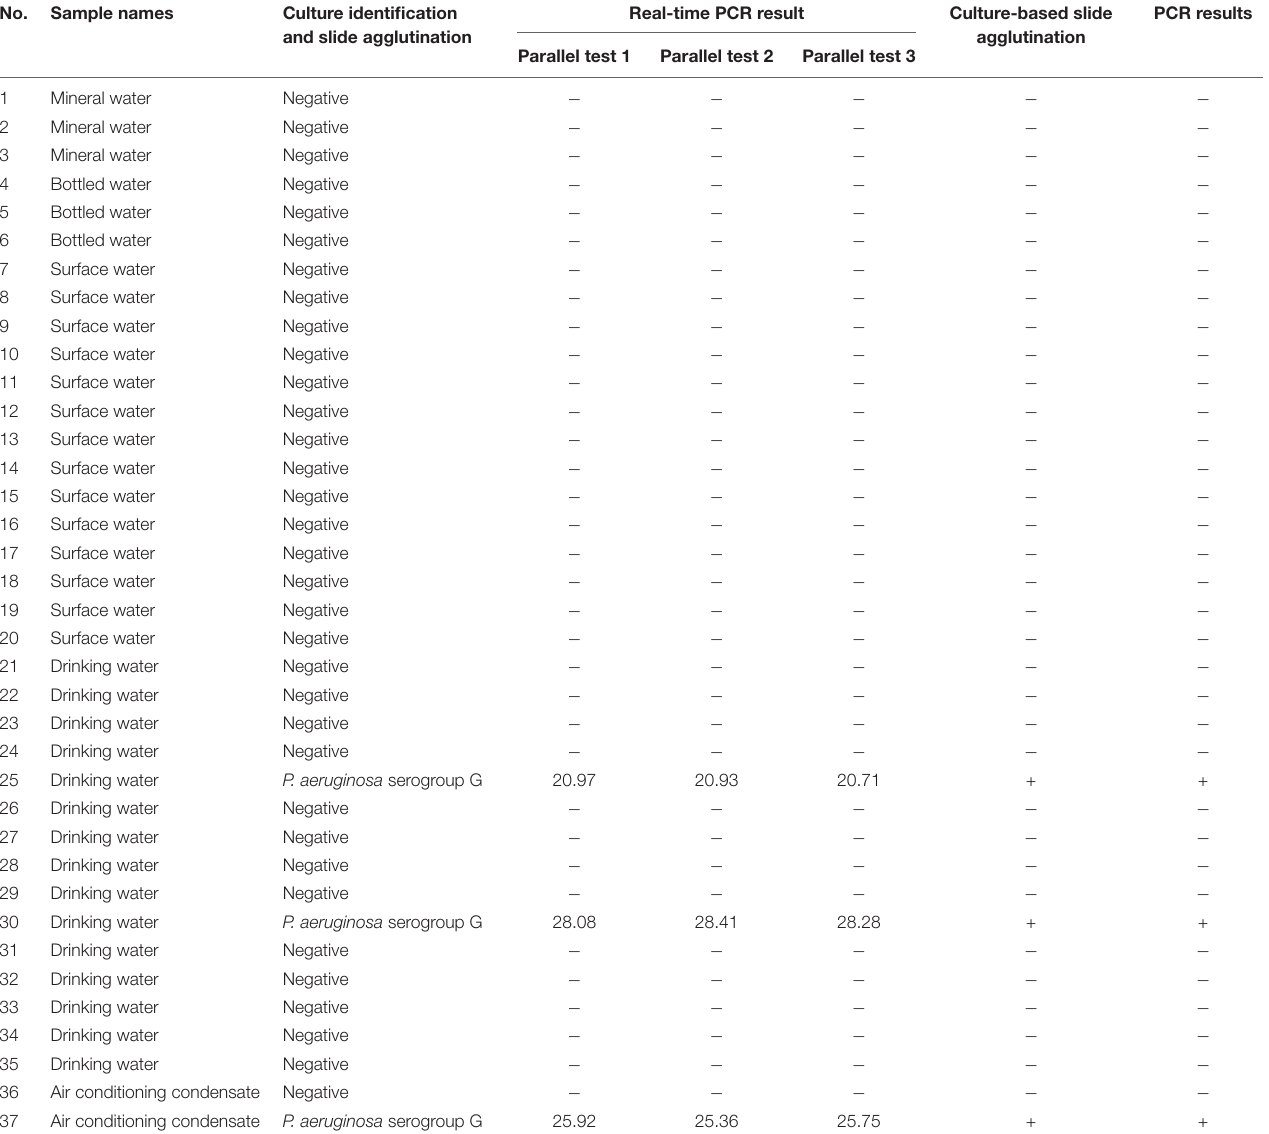
TABLE 3 | Culture-based identification of P. aeruginosa serogroup G, real-time PCR and PCR assay results from 37 water